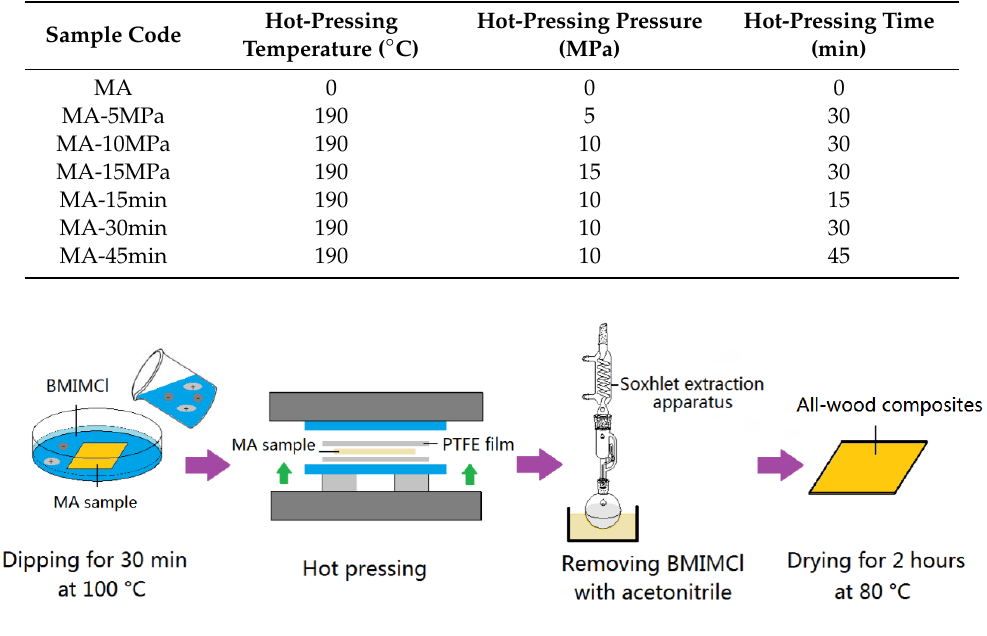
Figure 1. Preparation procedures of all-wood biocomposites